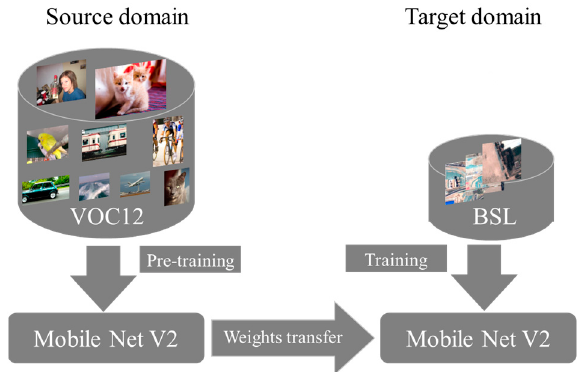
Figure 9. Model-based transfer learning.